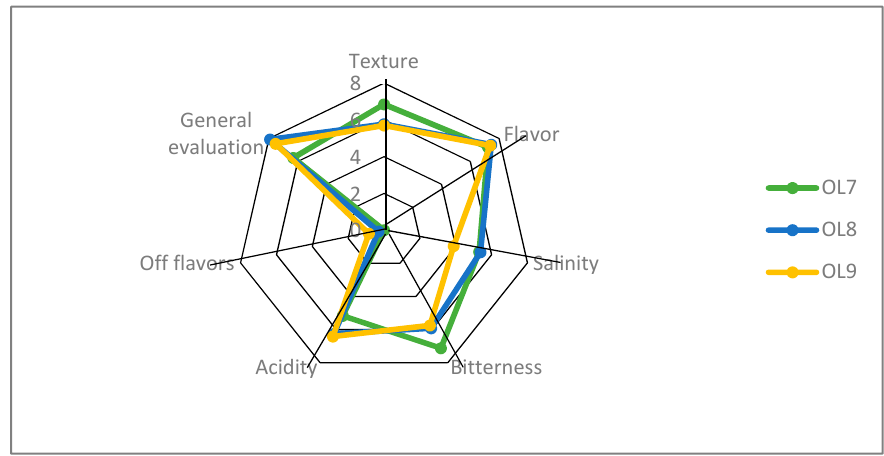
Figure 8. Sensory profiles of spontaneous (OL7), inoculated (10% NaCl) (OL8), and inoculated (7% NaCl) (OL9) fermentation of Cypriot green cracked table olives at 120 days of fermentation.